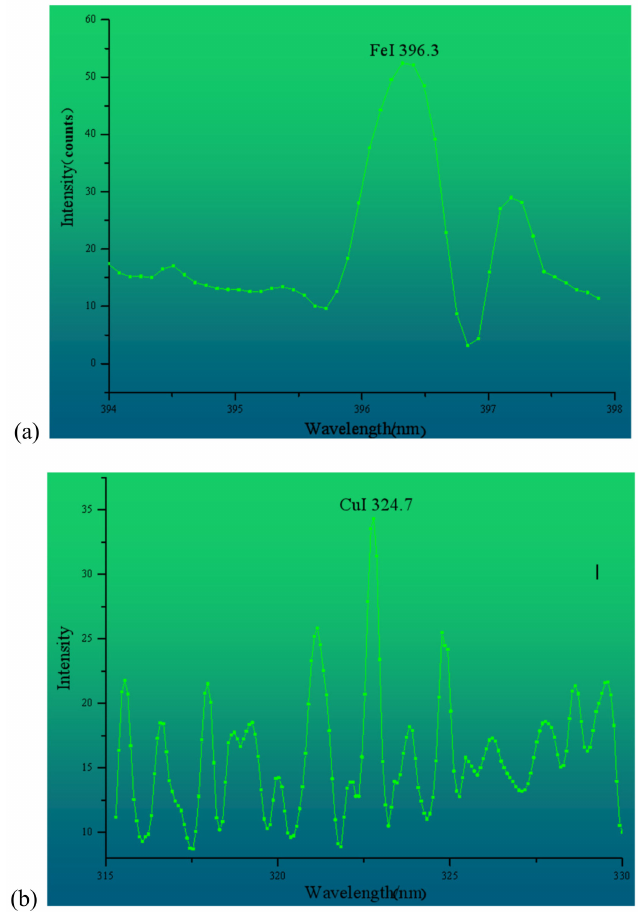
Figure 8. Magnification of characteristic peaks of ( a ) Fe and ( b )